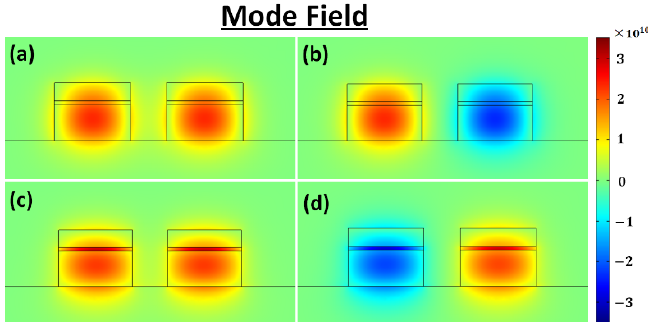
Figure 2. The electric field distributions of ( a ) the even quasi-transverse electric (TE) mode, ( b ) the odd quasi-TE mode, ( c ) the even quasi-TM mode, and ( d ) the odd quasi-TM mode.